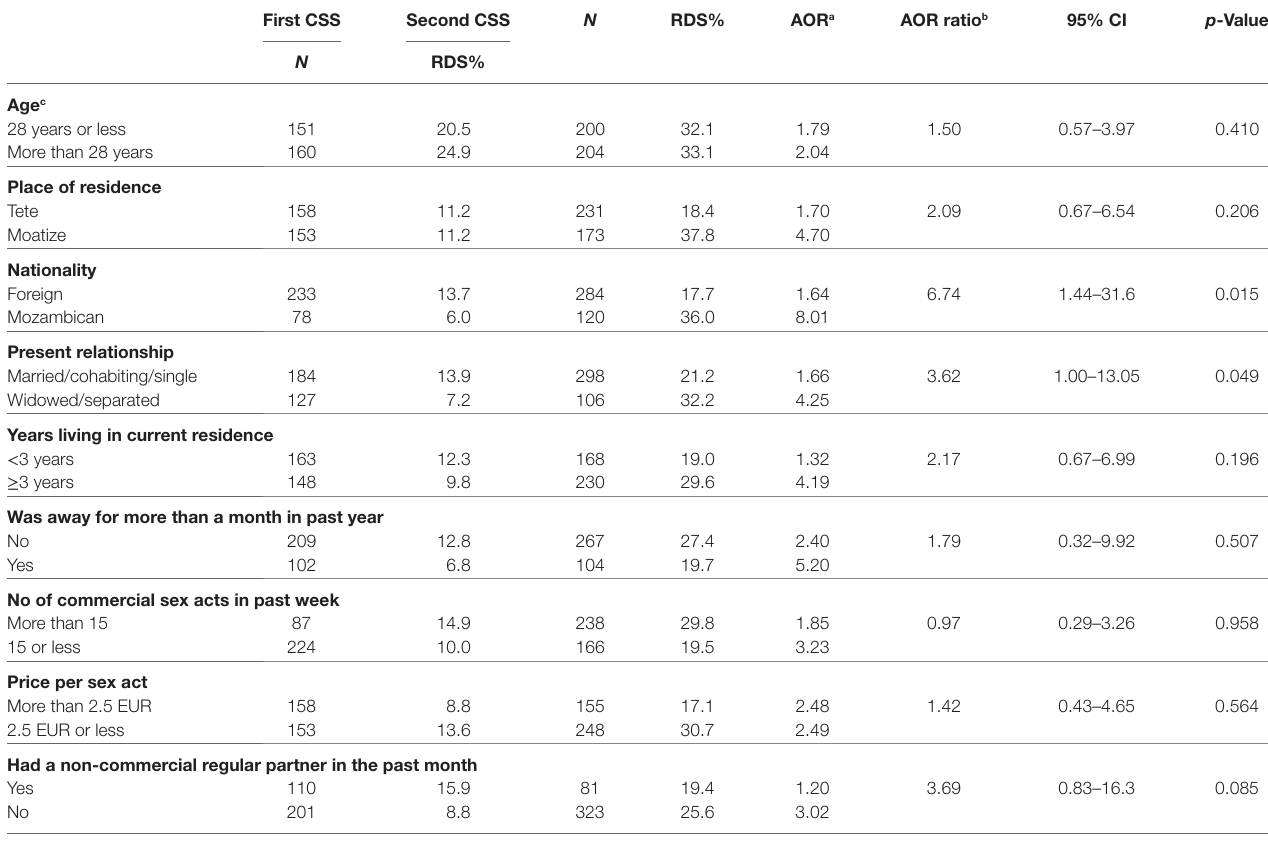
TaBle 4 | Changes in the proportion accessing all sexual and reproductive health services, by characteristics of female sex